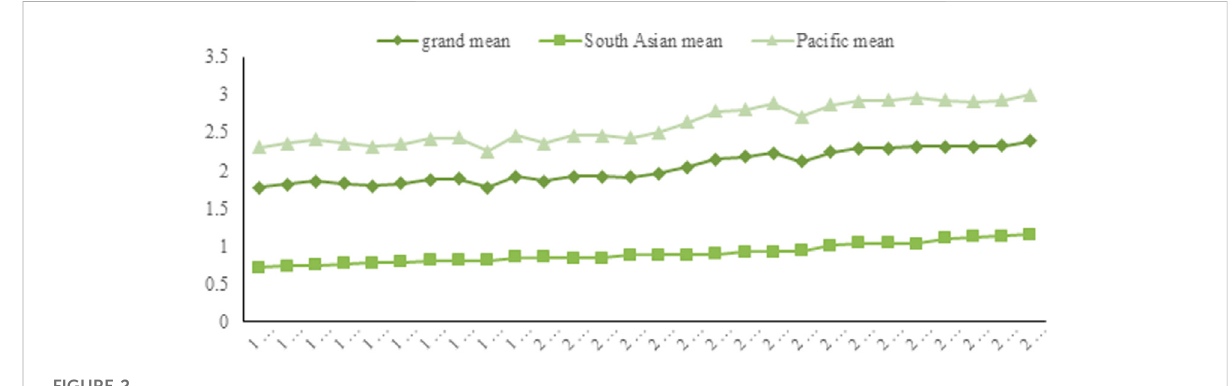
FIGURE 2 Average value of the ecological footprint in different